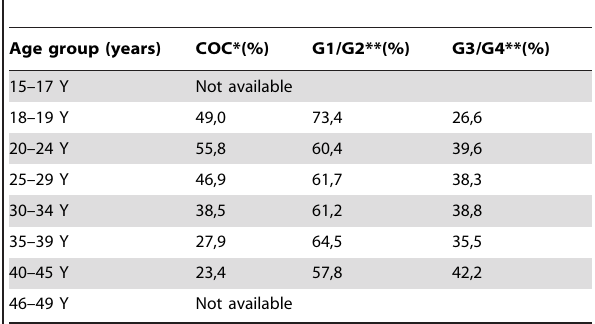
Table 4. Exposure of combined oral contraceptives, overall and by generation, in France - Results of Fecond survey,